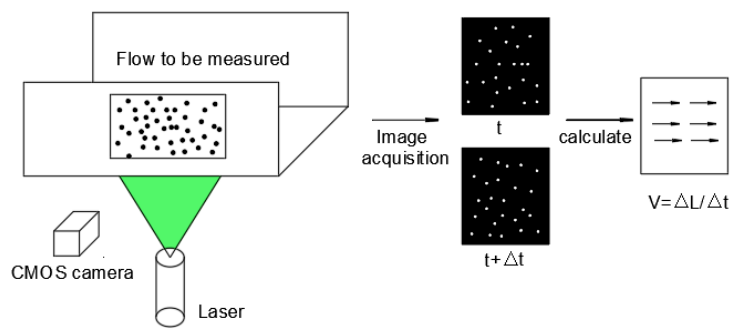
Figure 4. Schematic of the particle image velocimetry (PIV) system.